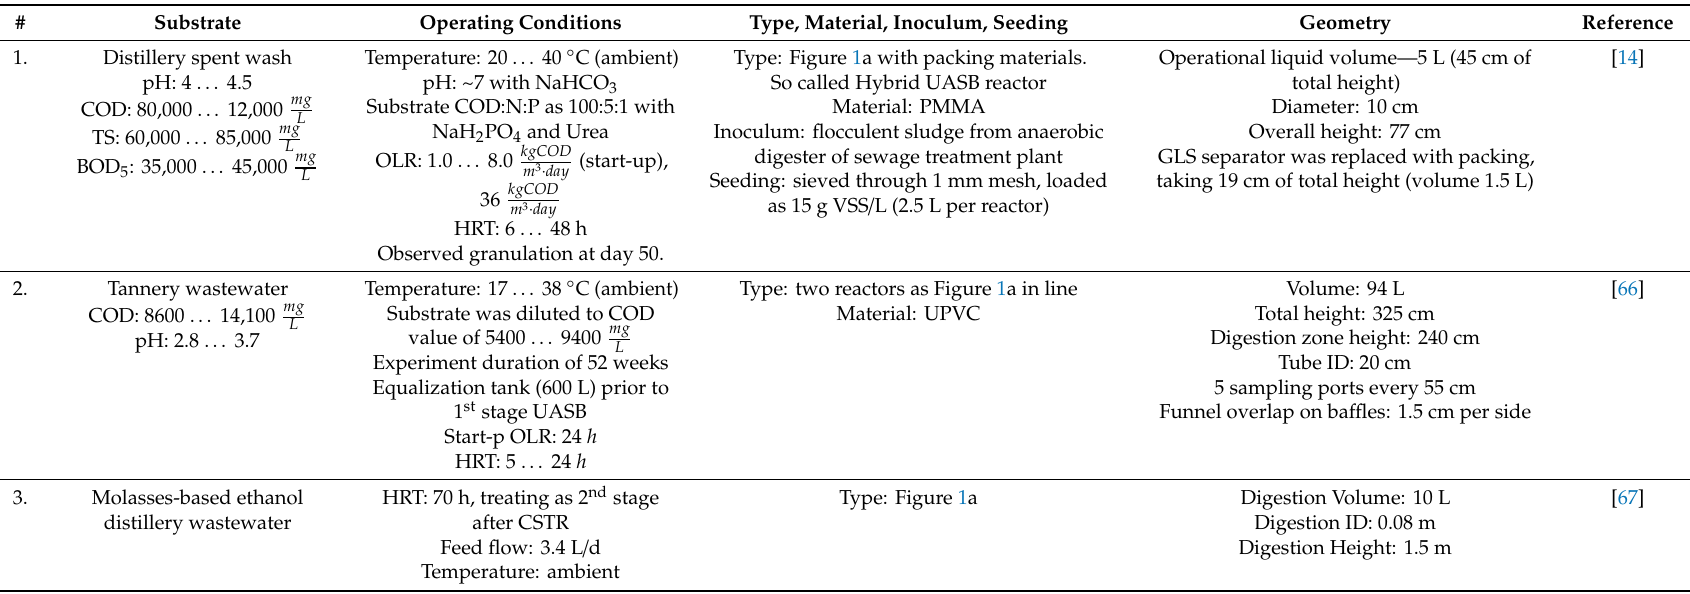
Table 3. Information on UASB modifications of multi-step reactors involving